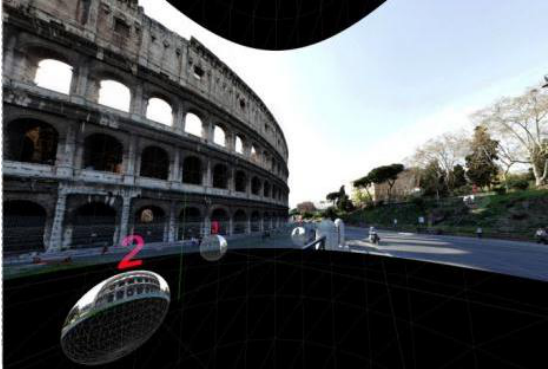
Figure 17. Interactive exploration of a panorama in a single 3D environment where the oriented panoramas and the 3D model are visualized at the same time